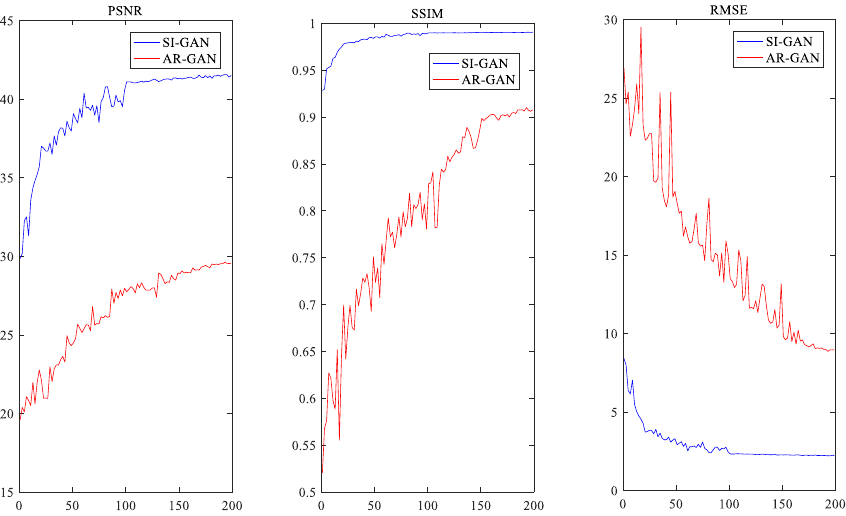
Figure 4. Averaged PSNR, SSIM, and RMSE Indicator values versus the number of epochs for SI-GAN and AR-GAN based on the [ 0 ◦ ,90 ◦ ] projection data reconstruction training from lung data.